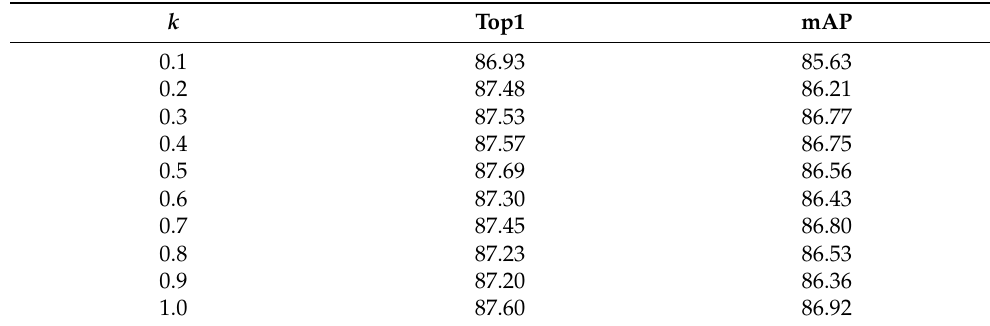
Table 6. Mineral recognition results based on fused features and top- k loss (%).